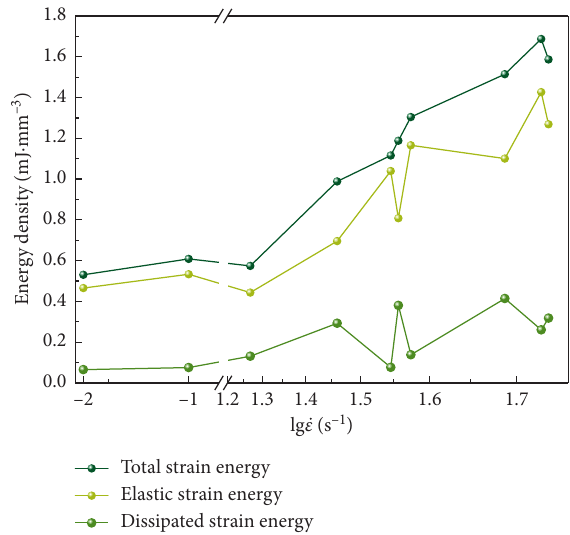
Figure 10: Strain rate effect on the strain energy of tested sandstone.